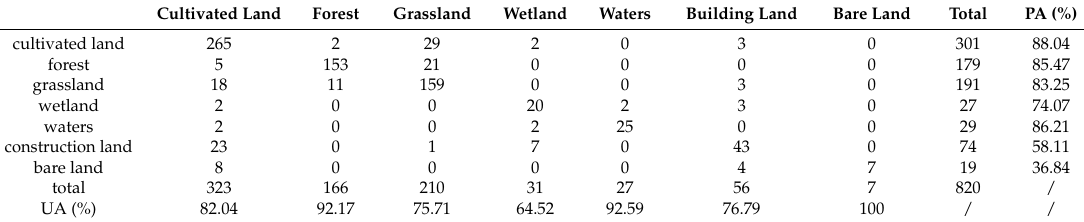
Table 3. Confusion matrix and kappa coefficients of the DCNN results.